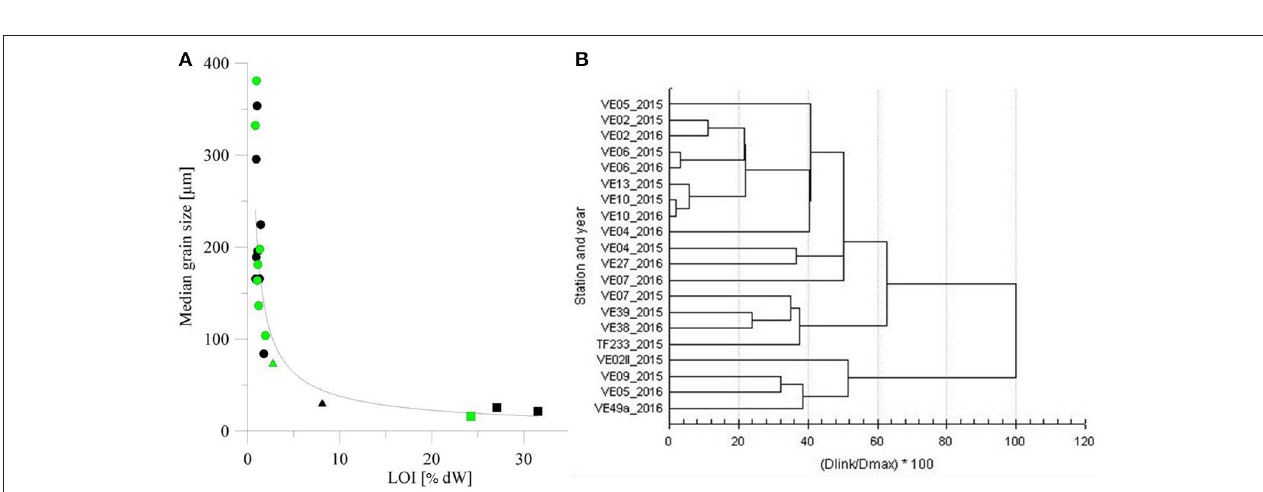
FIGURE 3 | (A) Correlation of the loss on ignition (LOI, in % dW) and the median grain size for samples collected during winter cruise AL449 (black) and spring cruise EMB123 (green). Dots indicate the coastal stations, triangles the intermediate stations, and squares the offshore stations. (B) Cluster analysis of surface grain size, surface LOI, and water depth of all stations against the distance value (D) in